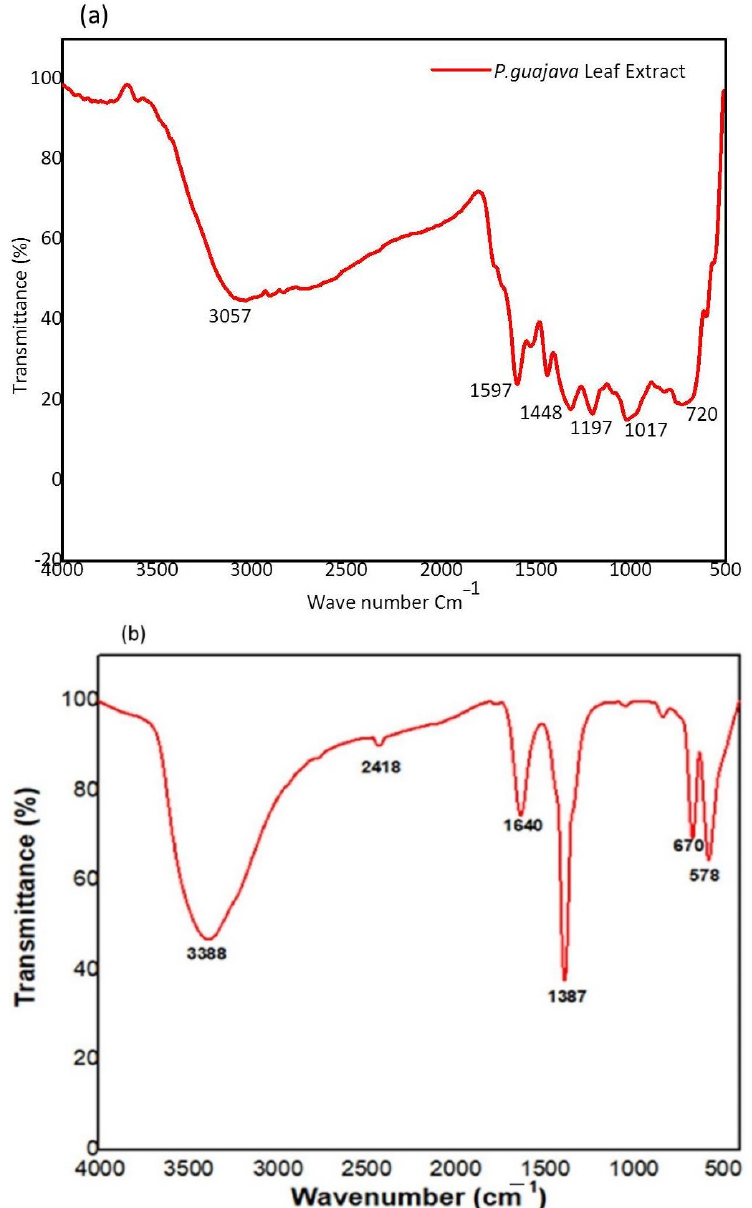
Figure 3. ( a ) FTIR spectrum of Psidium guajava l eaf extract and ( b ) Green synthesized P. guajava Co 3 O 4